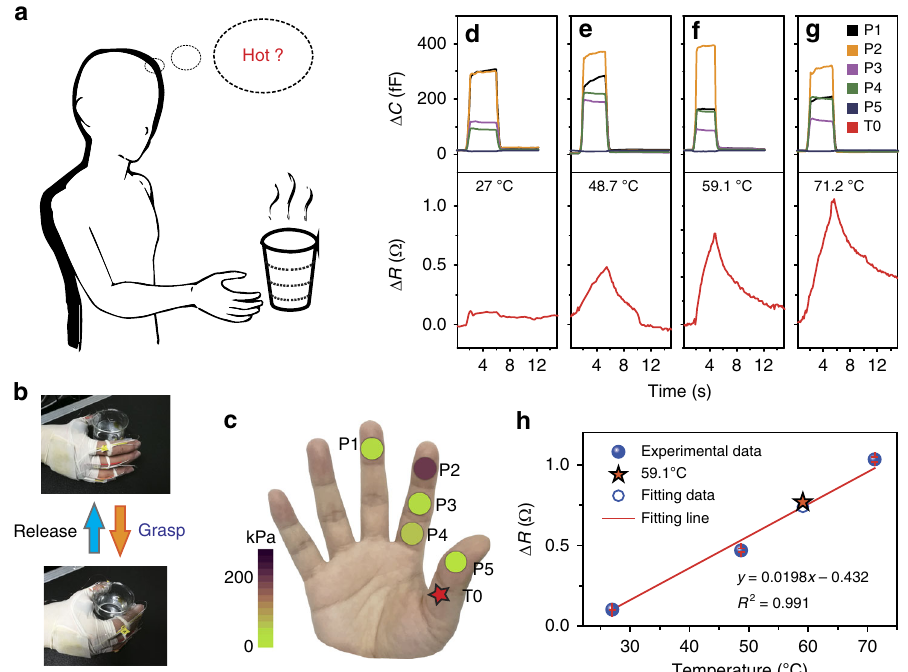
Fig. 6 The intelligent prosthetic hand with personalized SCMN con fi guration. a Schematic illustration of human hand picking up a cup with temperature detection at the same time. b Images show operations of the intelligent prosthetic hand to grasp (upper) and release (bottom). The procedures of grasping/releasing are also shown in Supplementary Movie 6. The intelligent prosthetic hand equipped with fi ve pressure sensors (P1, P2, P3, P4, and P5) and one temperature sensor (T0) on fi ngers. c Pressure distribution contour on the fi ngers when the intelligent prosthetic hand is grasping a water cup and sensing temperature of 59.1 °C. d – g The intelligent prosthetic hand grasps/releases cups fi lled with water with four different temperatures: 27 °C ( d ), 48 7 °C ( e ), 59.1 °C ( f ), and 71.2 °C ( g ). h Temperature estimation by the fi tting equation when the intelligent prosthetic hand is